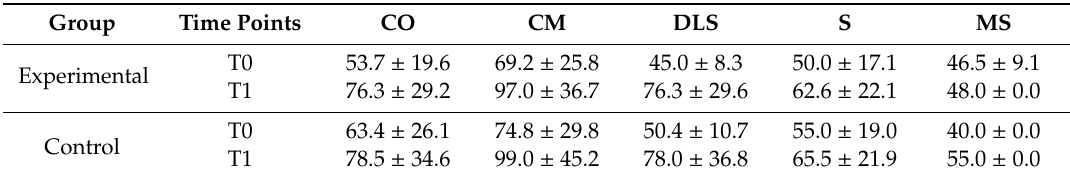
Table 7. Statistical results of the Vineland tests at baseline and the end of the reading sessions ( p > 0.05). Mean ± Standard Deviation is